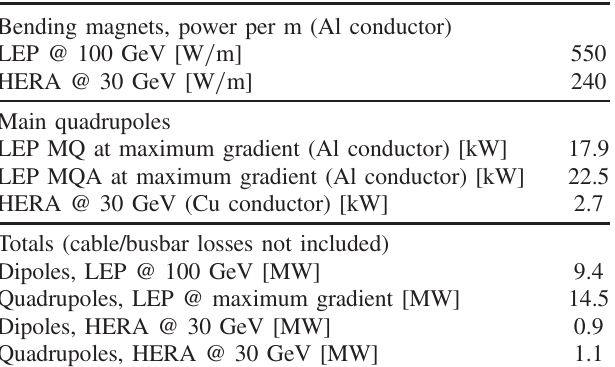
TABLE VI. Power consumption of LEP and HERA (electron ring) main dipoles and quadrupoles.